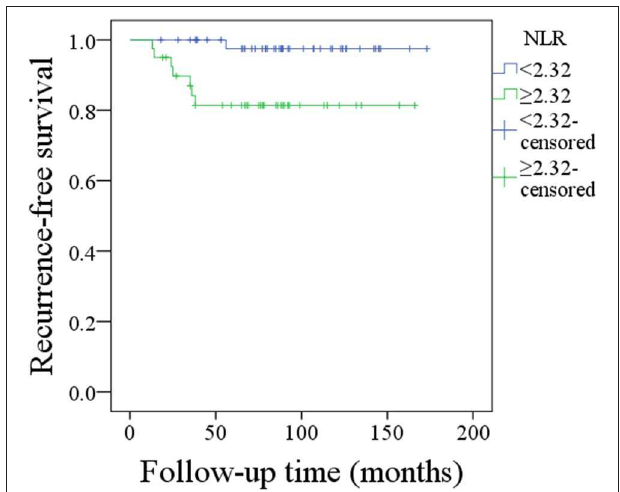
FIGURE 2 | Recurrence-free survival of patients with different neutrophil-to-lymphocyte ratios ( p = 0.010).